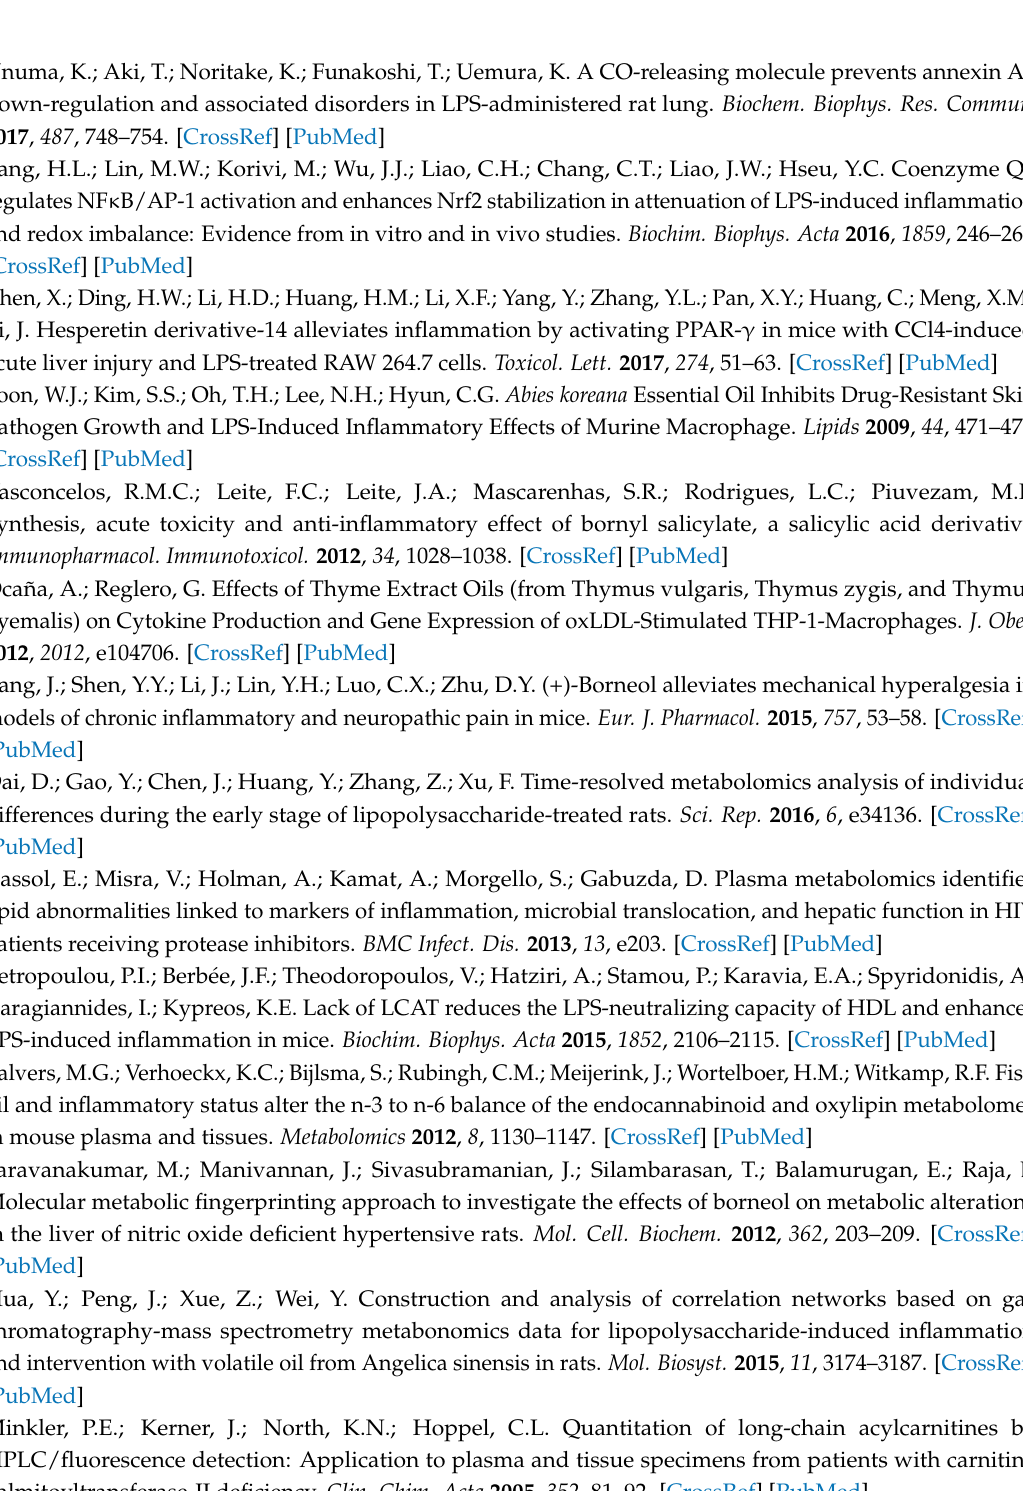
Sample Availability: Samples of the compounds synthetic borneol and natural borneol are available from the